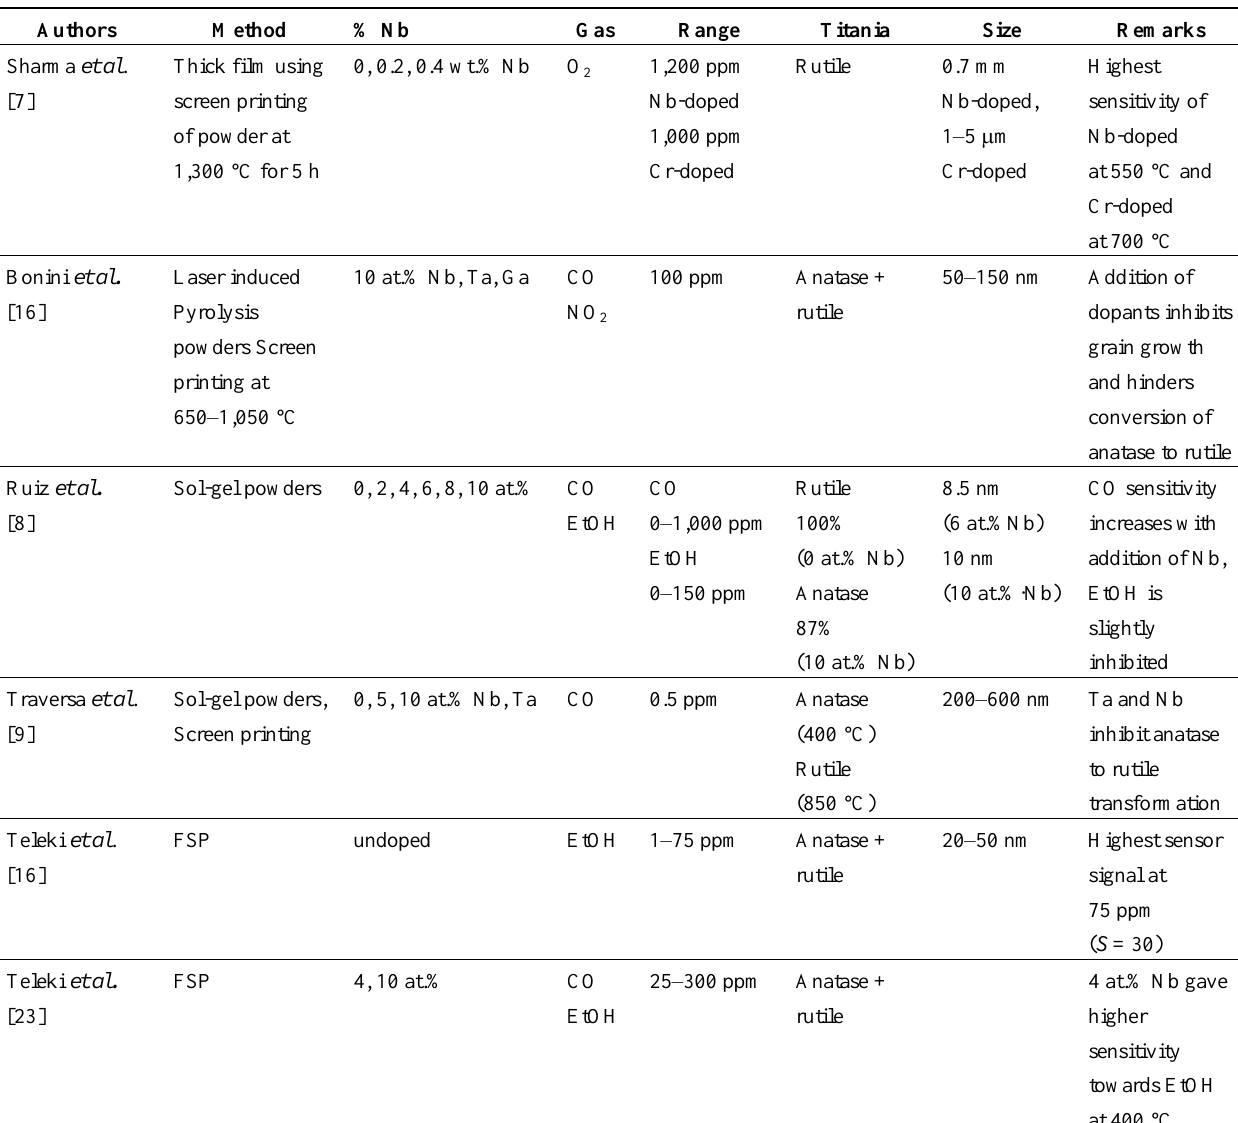
for gas sensing applications showing the 2